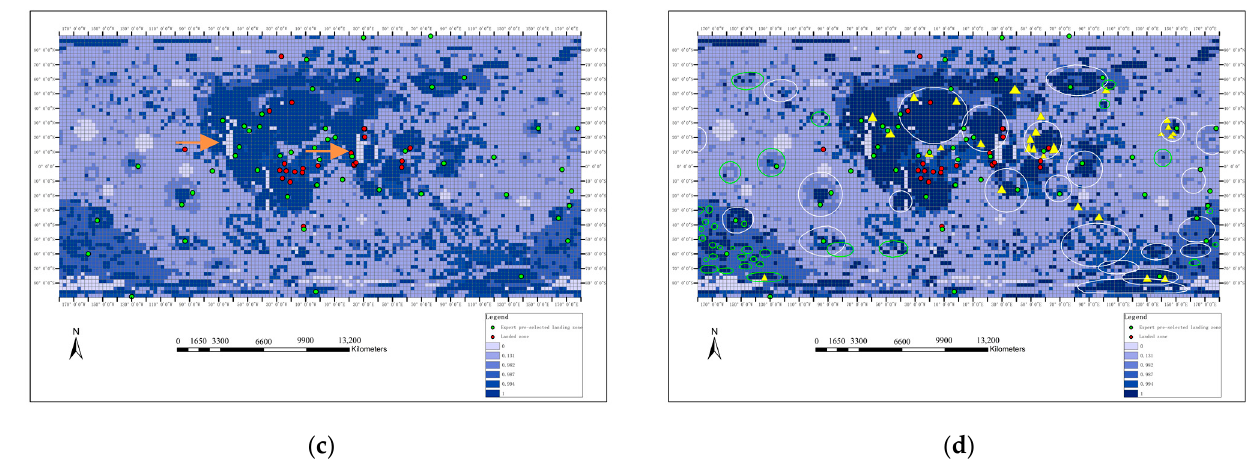
Figure 7. Posterior probability results from the weights of evidence applied to whole-moon landing zones selection. ( a ) Posterior probability results from two evidence layers (lunar crust thickness and roughness); ( b ) five evidence layers (thickness, roughness, slope, DEM, and gravity anomalies of the lunar crust); ( c ) the posterior probability results of the seven evidence layers; and ( d ) the posterior probability map overlays the distribution of impact craters/basins that may have excavated and exposed the lower lunar crust or lunar mantle material.